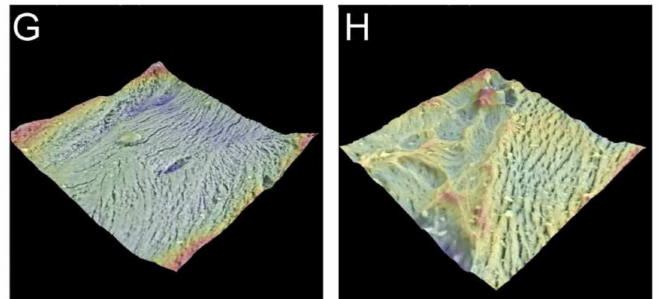
Figure 2. SEM images ( A – F ) and 3D surface reconstruction ( G , H ) of AEB ( A , C , E , G ) and ABB ( B , D , F , H ). Scale bars: ( A , B ): 200 µ m; ( C , D ): 100 µ m; ( E , F ): 30 µ m.